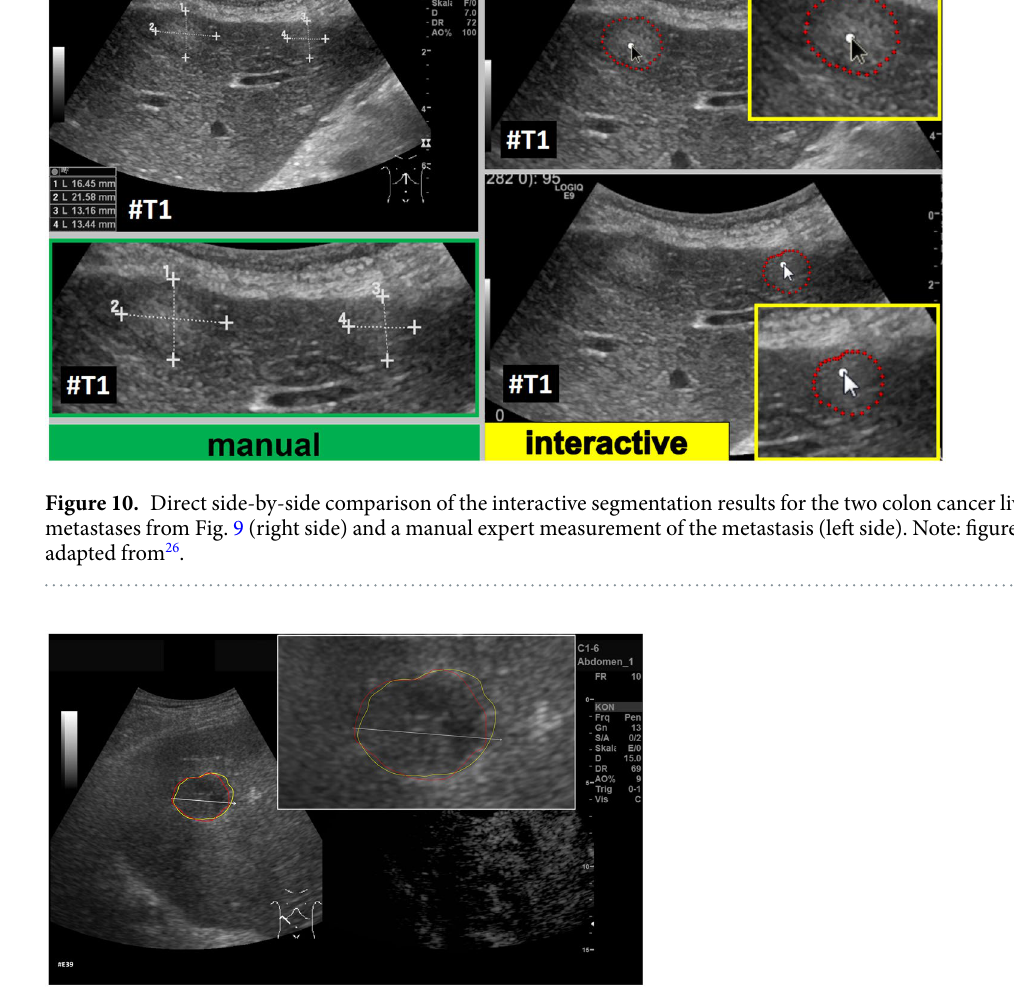
Figure 11. Comparison of manual and semi-automated segmentation of a pancreatic cancer liver metastasis. The native image with a zoomed view of the metastasis is presented (white box). The red outline represents the manual segmentation including the white arrow representing the manually drawn maximum diameter. The yellow line represents the result of the semi-automatic